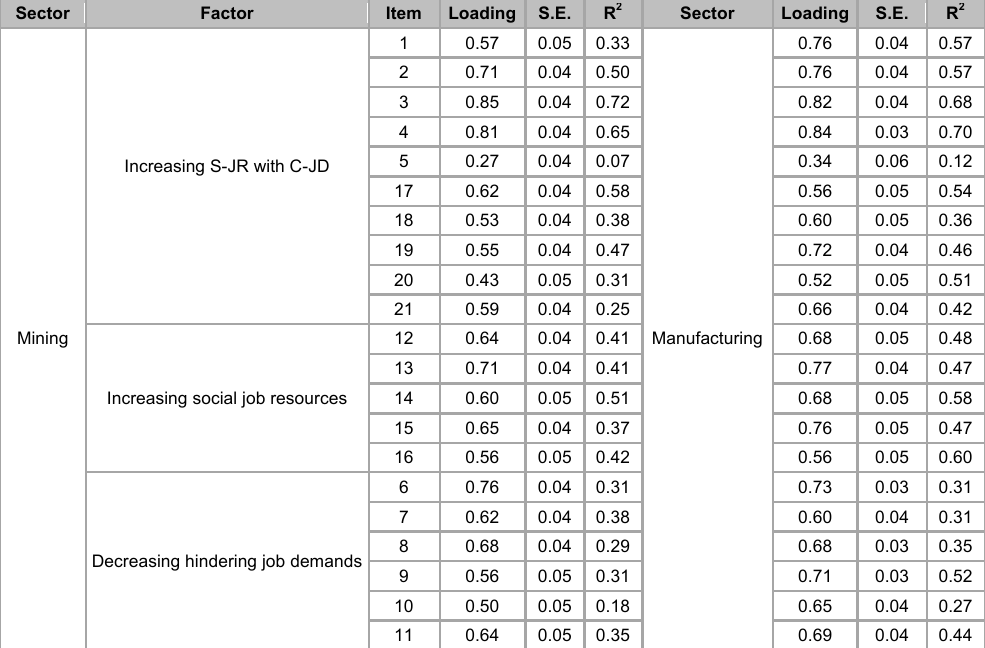
Standardised factor loadings, standard errors and explained variance of the items for the job crafting factors Sector Factor Item Loading